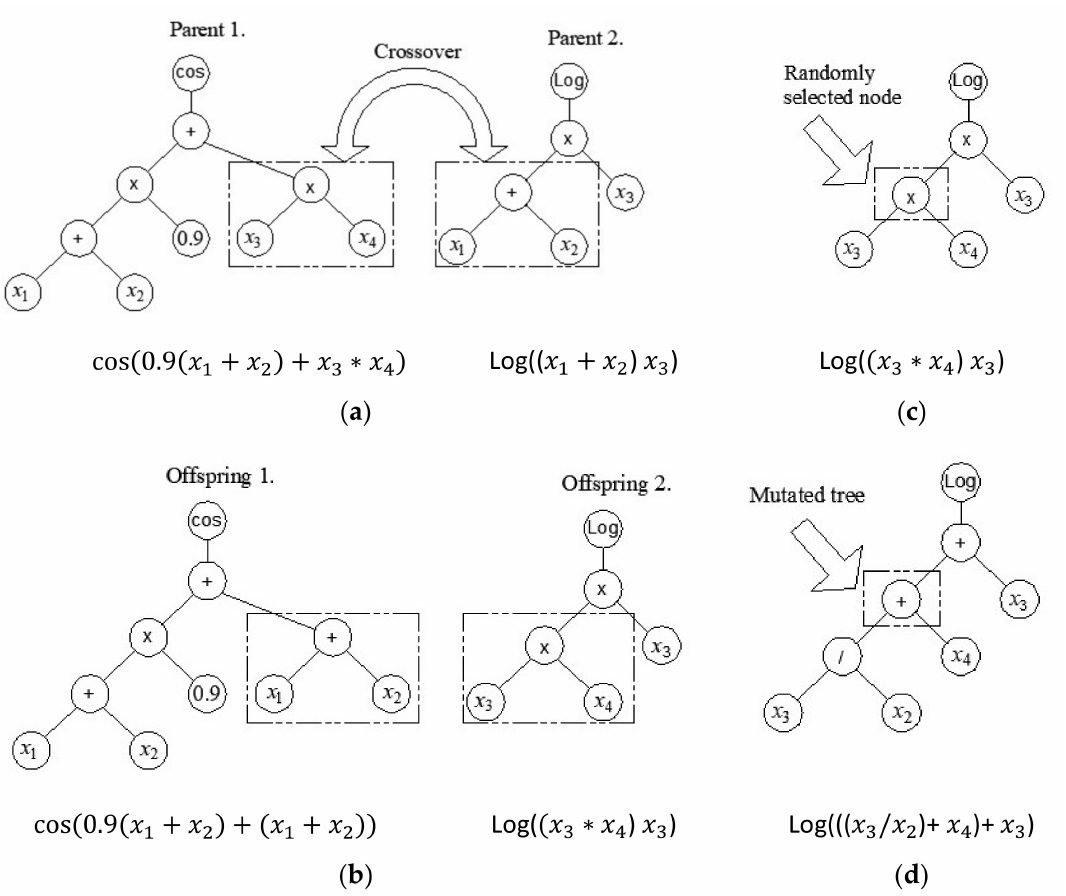
Figure 3. Crossover and mutation operation in MGGP: ( a ) random selection of parent tree nodes; ( b ) exchange of parents’ genetic material; ( c ) random node selection in tree mutation; and ( d ) mutation of a randomly selected part of a